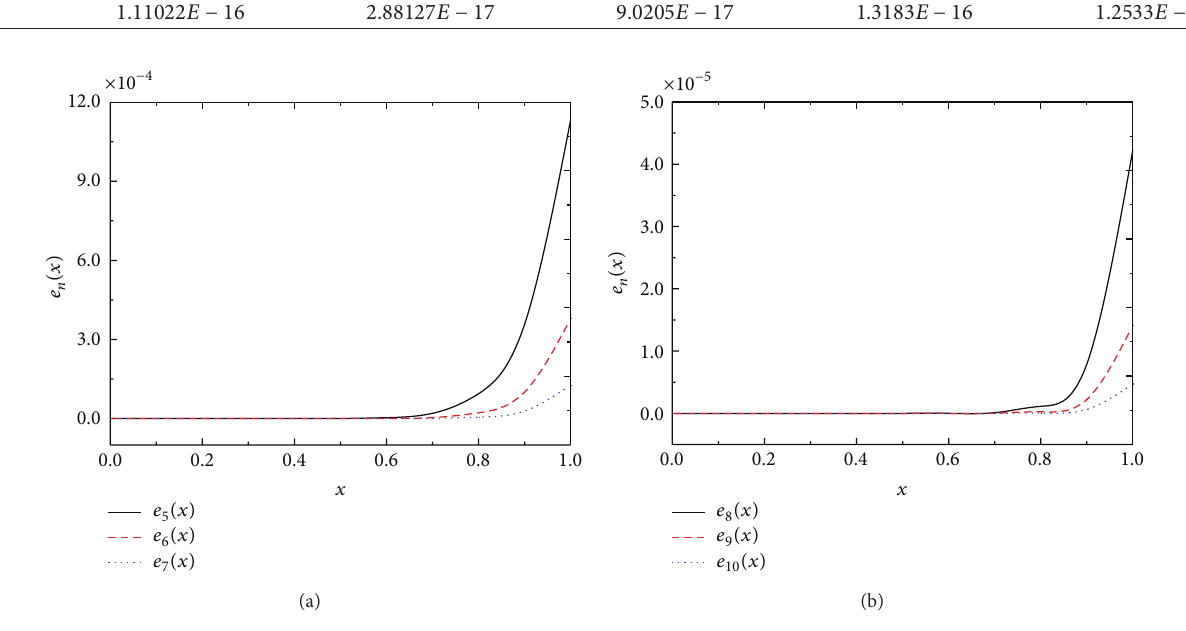
Figure 1: Absolute error functions 𝑒 𝑛 (𝑥) of Example 5.